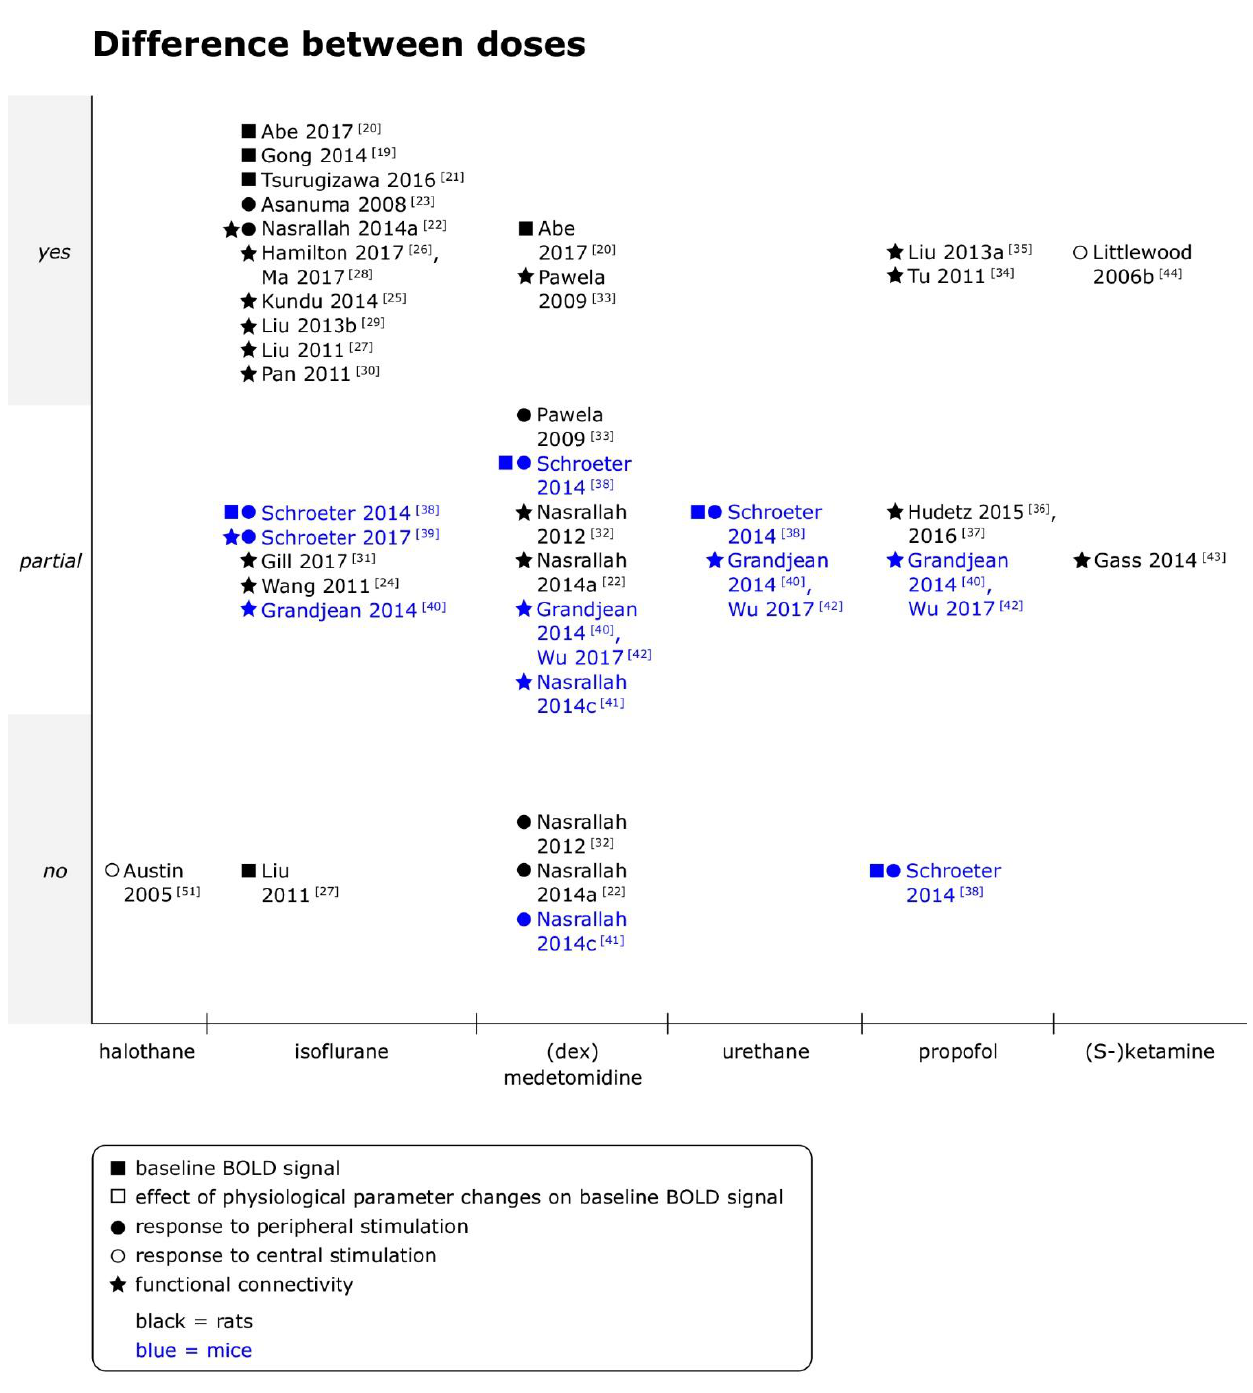
Figure 1. Effects of anesthetic doses on baseline blood oxygen level dependent (BOLD) signal, responses to peripheral and central stimulation and functional connectivity in rats and mice. Yes = differences between doses were clearly observed; partial = differences between doses were observed for some outcomes, analyses or animals, but not consistently, or quantitative differences were reported, but statistical significance unclear; and no = no differences between doses were observed. When datasets were re-analyzed, findings were pooled and one data point per specific comparison (i.e., per anesthetic per type of functional magnetic resonance imaging (fMRI)) displayed. (dex)medetomidine = medetomidine or dexmedetomidine was studied. (S-)ketamine = ketamine or S-ketamine was studied. Not all references are discussed in the text [43,44], but a summary of the main findings as well as the doses of anesthetics are provided for references with the symbols ◼ or in Supplementary Materials Tables S2 and S5, with symbols ⚫ or in Supplementary Materials Tables S3 and S5, and for references with symbol in Supplementary Materials Tables S4 and S6.